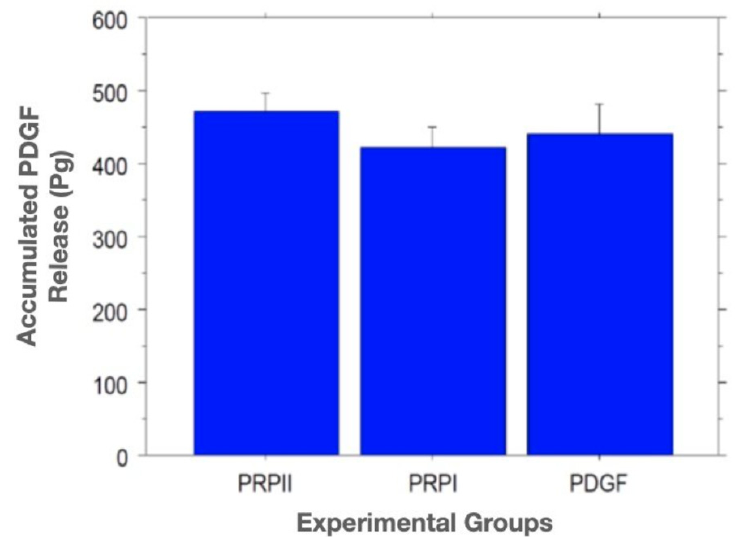
Figure 6. Graph showing no significant difference between the experimental groups for the accu- mulated release of PDGF from the gelatin–HPA among the groups. One-way ANOVA p value = 0.5228.